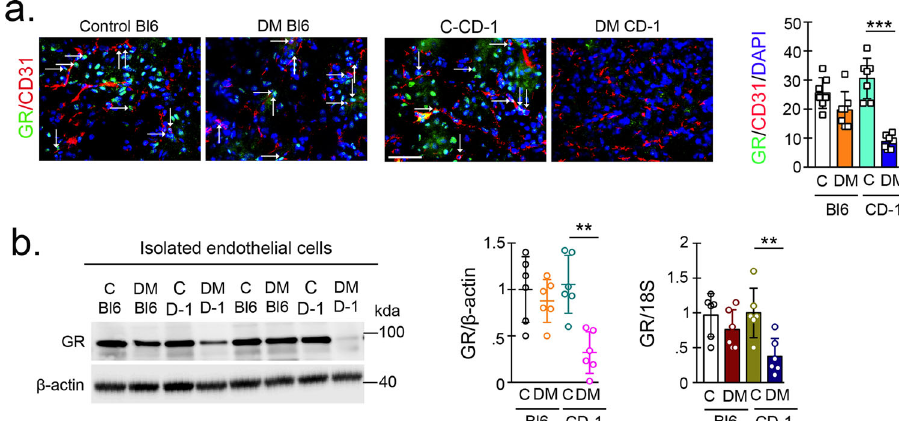
Fig. 1 Loss of endothelial GR results in a fi brogenic phenotype in the kidneys of diabetic mice. a Immuno fl uorescence analysis was performed in the kidneys of control and diabetic CD-1 and C57BL/6 mice using FITC-labeled GR, rhodamine-labeled CD31 and DAPI (blue). Representative merged images are shown; original magni fi cation ×400. Scale bar 50 µ m. N = 7 biologically independent mice/group combined from three separate experiments. Quanti fi cation of GR/CD31 double-labeled cells is shown. Data are mean ± SEM. b Western blot and qPCR analysis of GR protein and mRNA levels in isolated endothelial cells from the kidneys of control and diabetic CD-1 and C57BL/6 mice. Endothelial cells were isolated and cultured from six biologically independent mice/group. Three independent experiments were performed. Densitometry analysis of six samples/group is shown and is normalized to β - actin. mRNA expression from six independent cell culture samples was analyzed and normalized to 18S. Two independent experiments were performed in triplicate. Data are mean ± SEM. For all panels, two-way ANOVA was used for the analysis of statistical signi fi cance. Signi fi cance * p < 0.05, ** p < 0.01, *** p < 0.001. Source data are provided in the source data fi